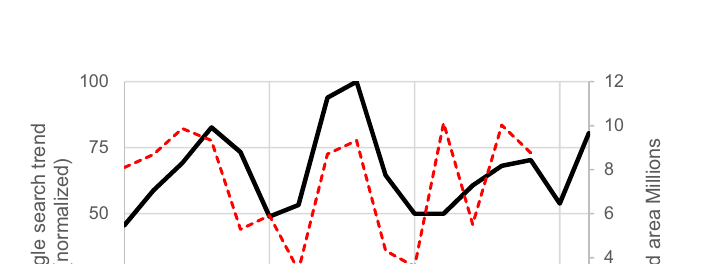
Table 1. Parameter values for a base run simulation.